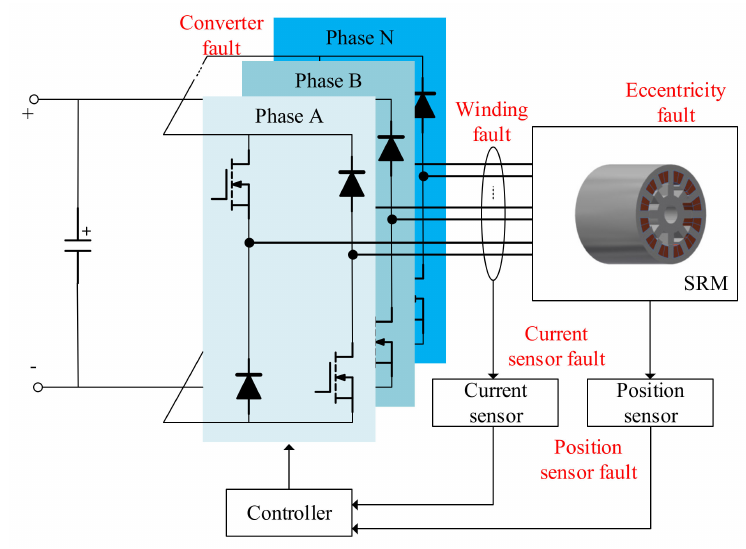
Figure 20. SRM drive system and location of different faults edited from [10].